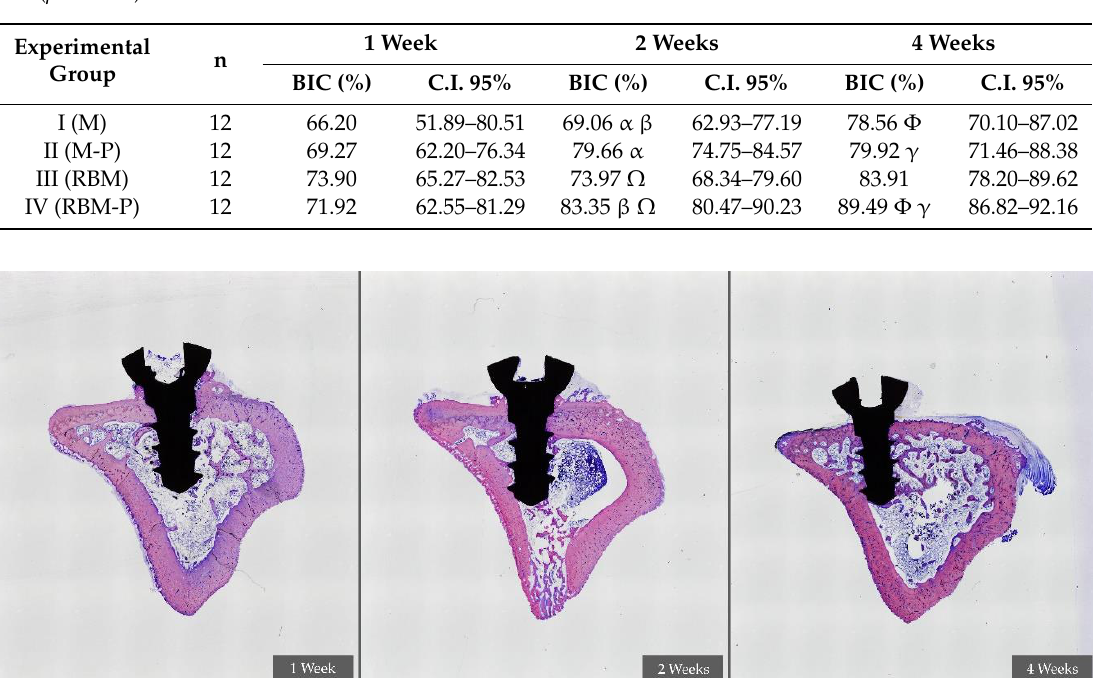
Table 2. BIC percentages and standard deviations of each experimental group obtained by histological evaluation at one, two, and four weeks. No statistically significant di ff erence was observed between groups in the first week ( p < 0.05). At two weeks, there were significant di ff erences between ( α ): M and M-P ( p = 0.018); ( β ): M and RBM-P ( p = 0.001); and ( Ω ): RBM and RBM-P ( p = 0.035). At four weeks, significant di ff erences appeared between ( Φ ) M and RBM-P ( p = 0.018) and ( γ ) M-P and RBM-P ( p = 0.024).